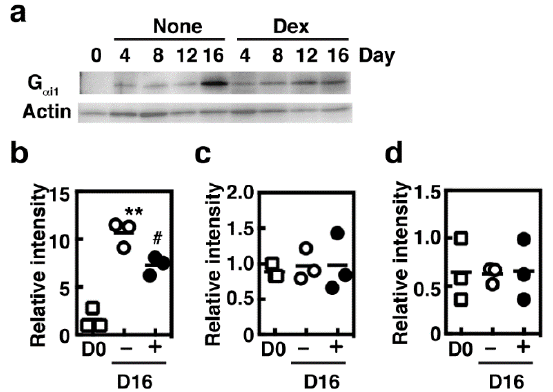
Figure 4. BMMCs were co-cultured with Swiss 3T3 fibroblasts in the presence (Dex) or absence (None)